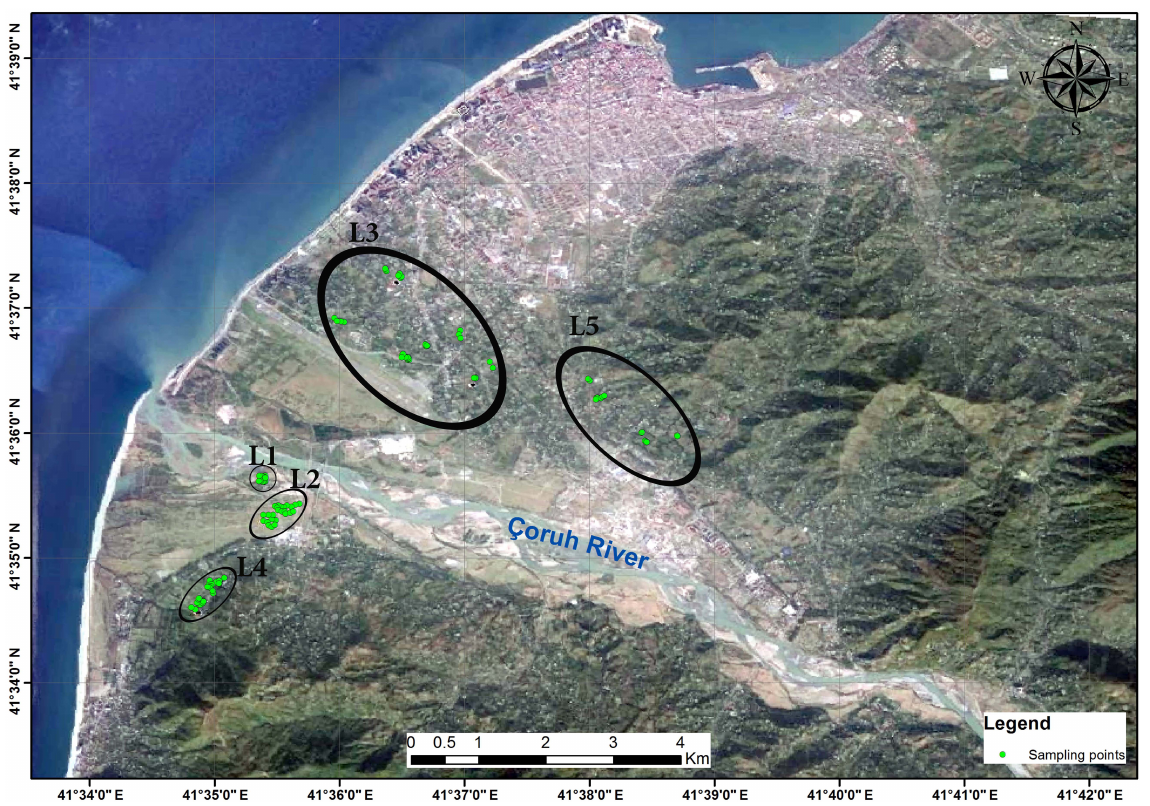
Figure 2. Location of the sampling points in the Batumi delta (L1, L2, L3, L4 and L5 represent the sampling sites. L1 is located in the active delta, L2 and L3 in lower deltaic plain, and L4 and L5 in upper deltaic plain). Table 2. Summary statistics of soil